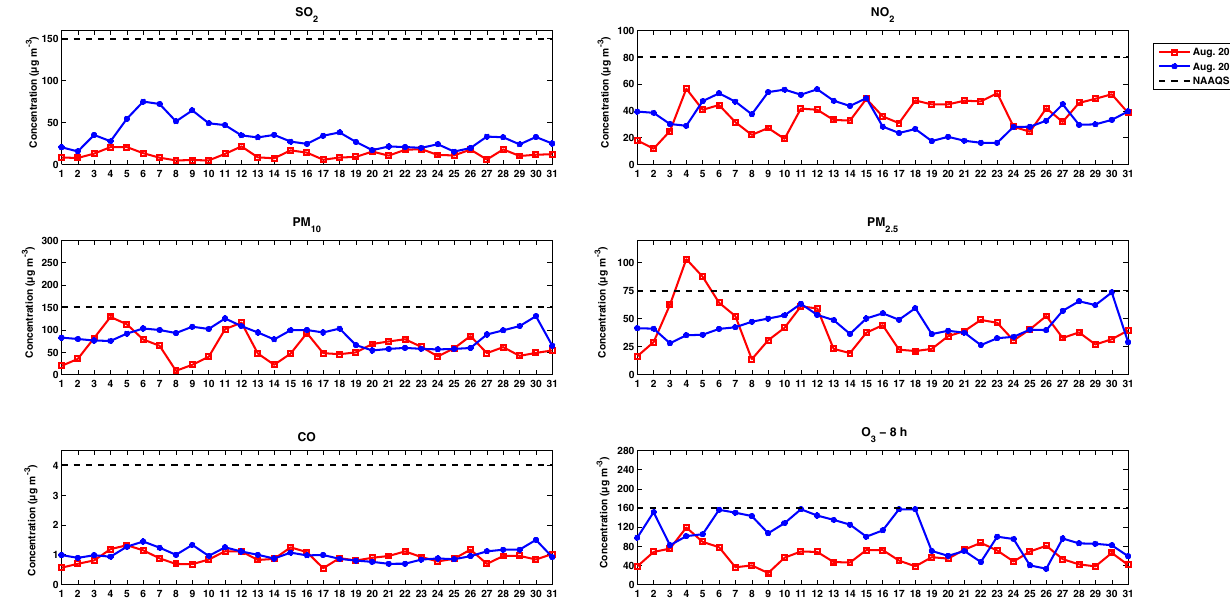
Figure 3. Day-to-day variations in SO 2 , NO 2 , PM 10 , PM 2 . 5 , CO and O 3 -8h (over an average of 8h) at CCM station in August 2013 and August 2014 (CST). Observed data for August 2013 and August 2014 are indicated in blue and red respectively. NAAQS are indicated with a black dotted line.